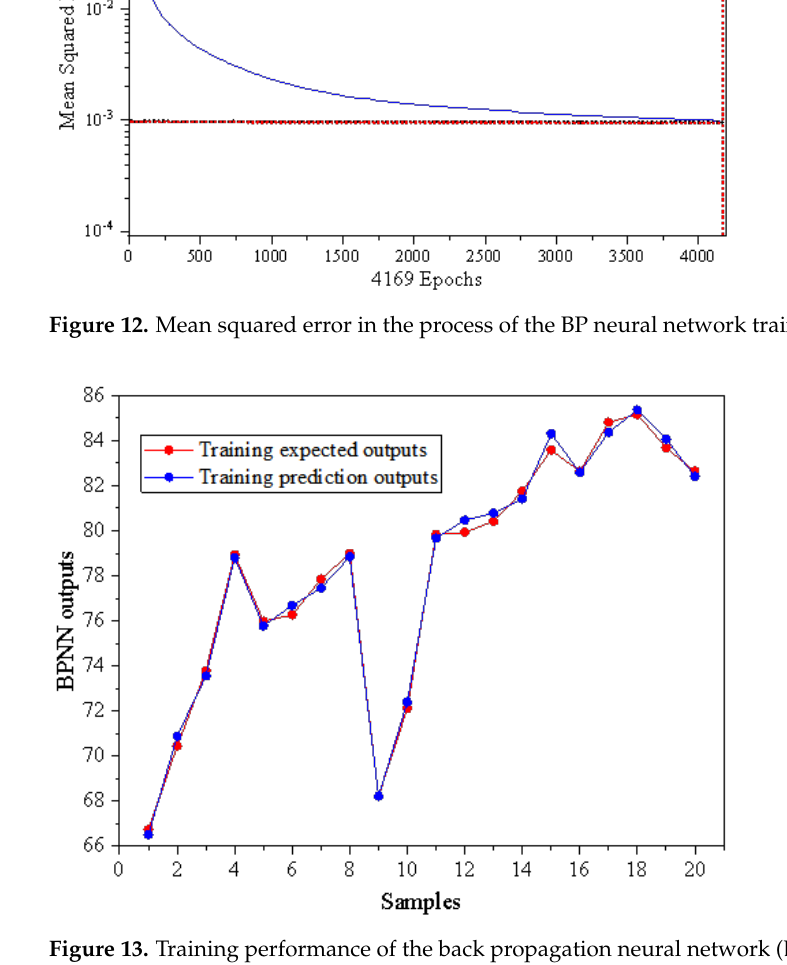
Figure 13. Training performance of the back propagation neural network (BPNN) model.